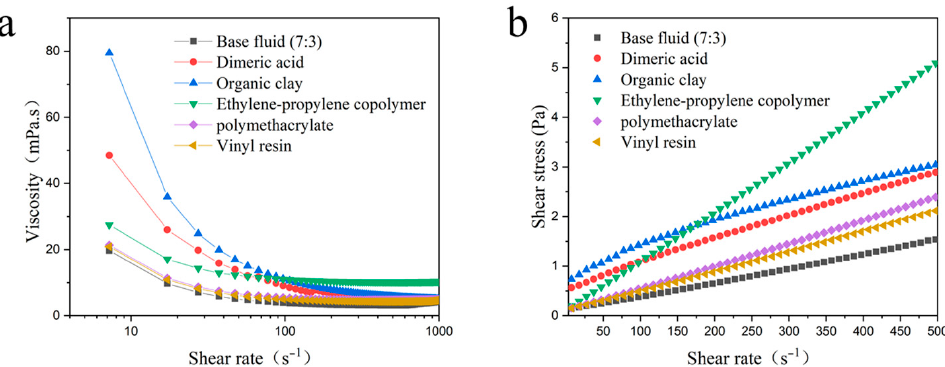
Figure 10. Haake rheological curve of drilling fluid with 4% different additives; ( a ) viscosity with shear rate; ( b ) graph of shear stress variation with shear rate.